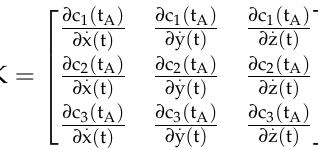
Figure 5. The 99th percentile of the trajectory dispersion on the B-Plane [16] of